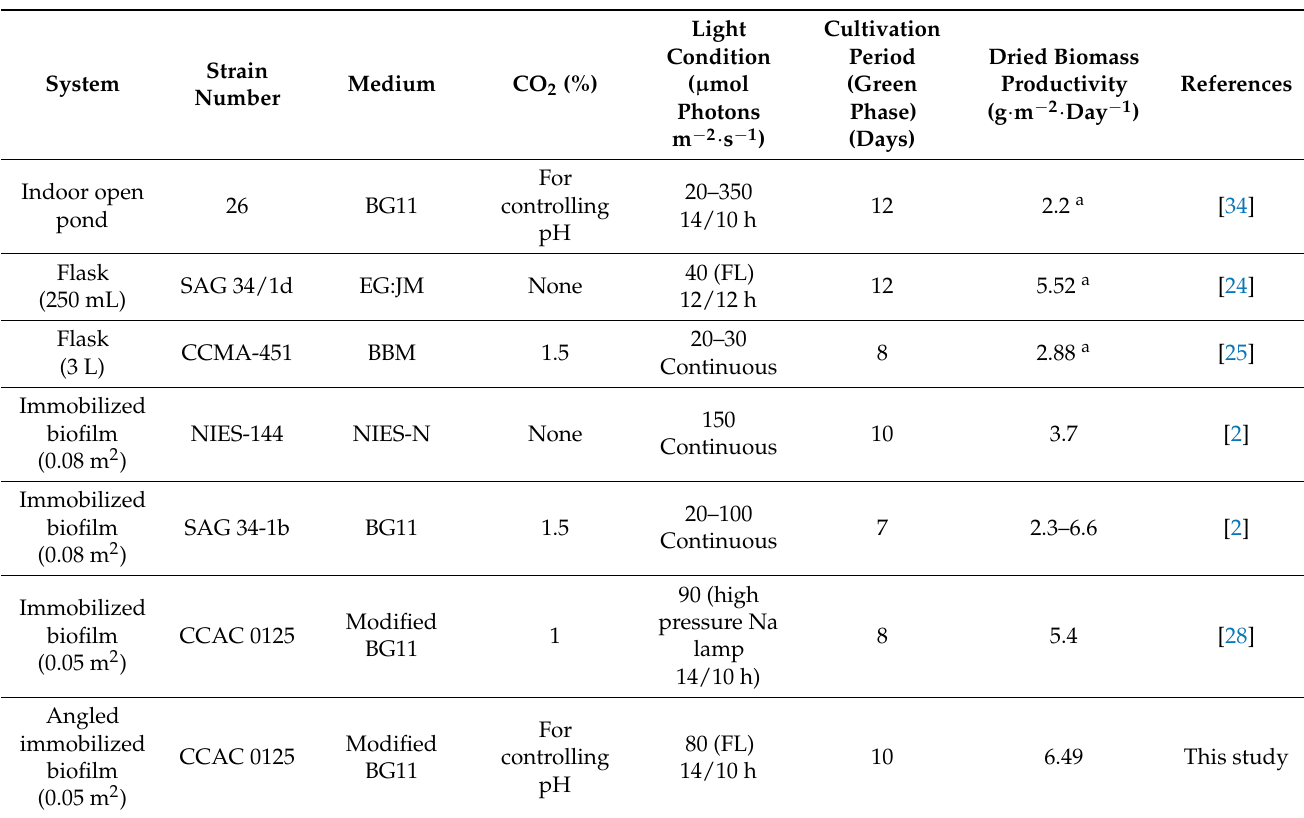
Table 1. Comparison of H. pluvialis green phase cultivation results in an angled biofilm-based photobioreactor system (this study) with other cultivation systems based on the surface